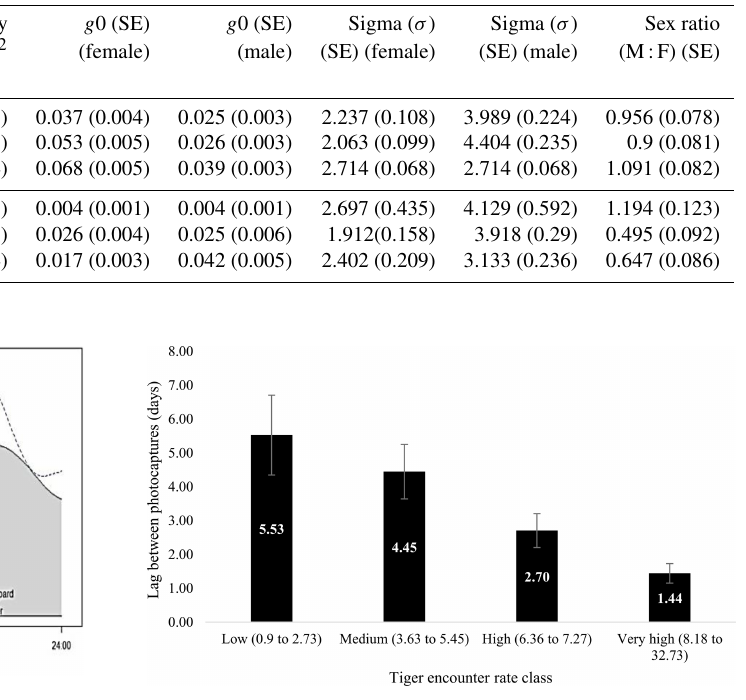
Figure 4. Activity peaks and temporal overlap between tigers and leopards in Pench Tiger Reserve, Madhya Pradesh. Table 2. Quantile regression coefficients of leopard densities with tiger densities in Pench Tiger Reserve, Madhya Pradesh, during